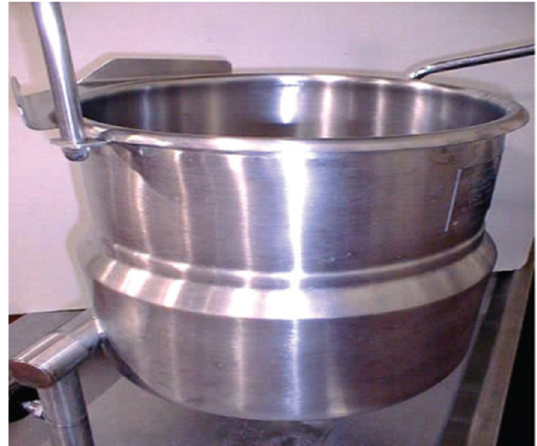
Figure 1. A conventional steam jacketed kettle used to heat batches of food materials. The kettle chamber is typically 1.5 m in diameter with a 1.5 m depth.